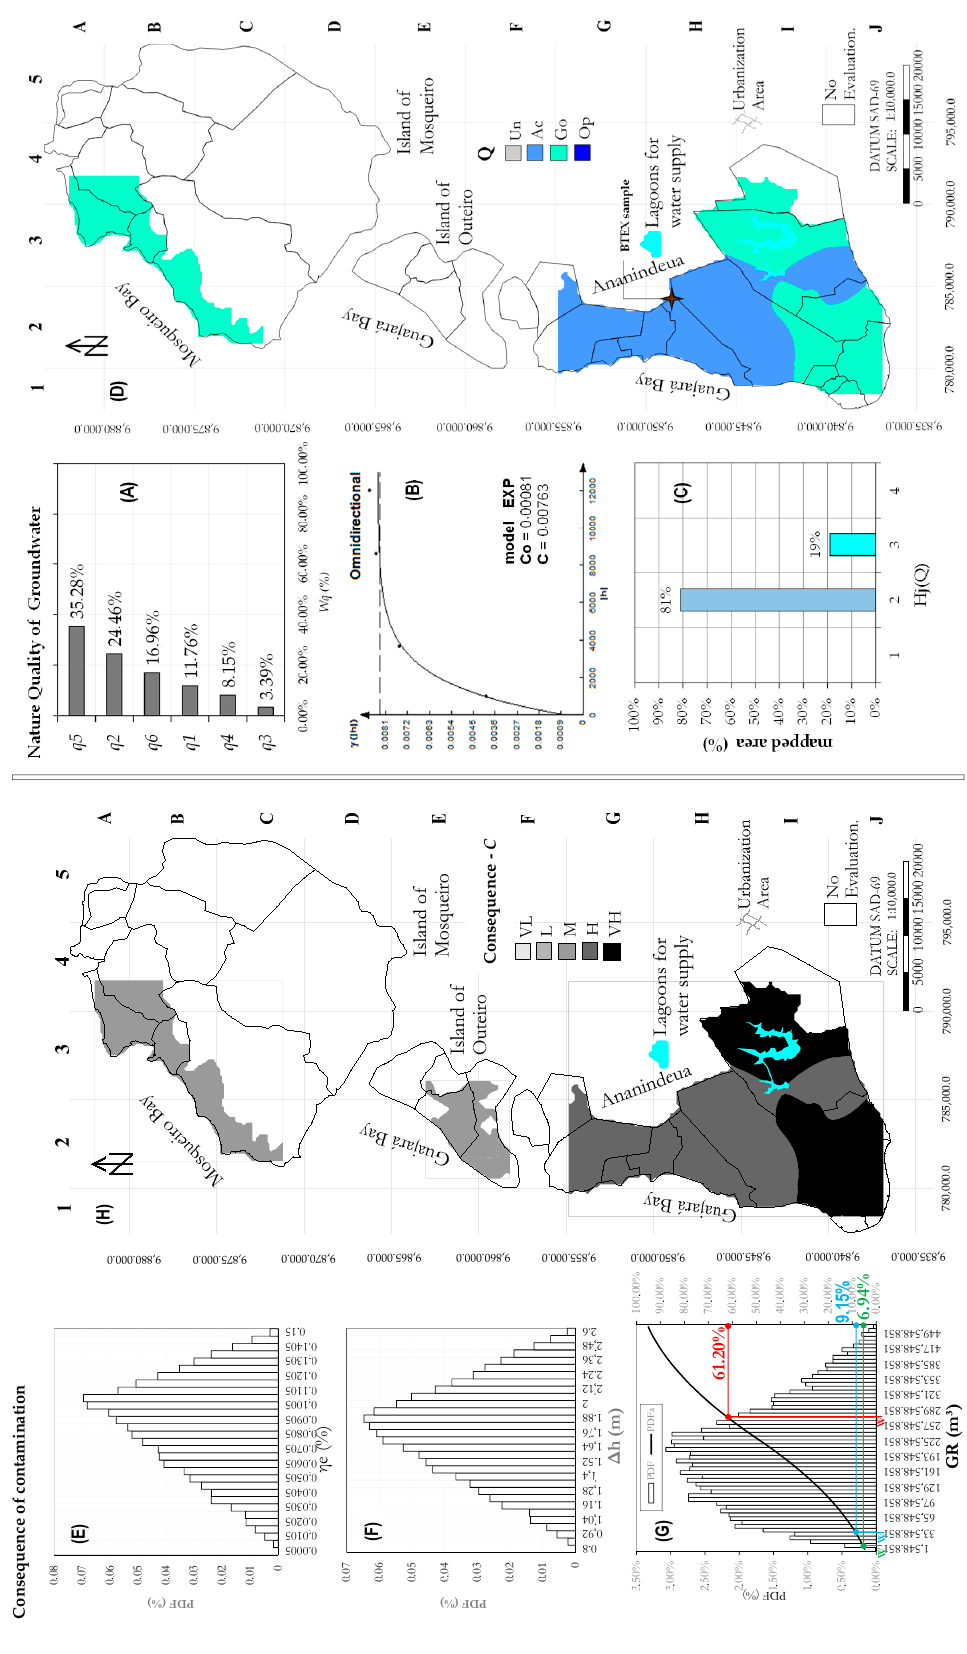
Figure 6. ( A ), ( B ), ( C ), ( D ) Quality groundwater; ( E ), ( F ), ( G ), ( H ) consequence of contamination. Figure 6. ( A – D ) Quality groundwater; ( E – H ) consequence of